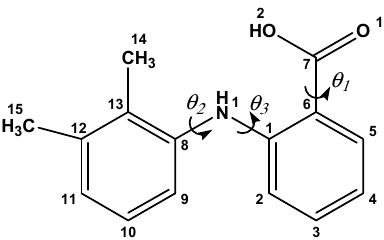
Figure 2. Mefenamic acid molecule, with the numbering scheme used in this work. Definition of torsional angles: θ 1 is the angle involving O1-C7-C6-C1, θ 2 is the angle involving C1-N1-C8-C13 and θ 3 is the angle involving C6-C1-N1-C8.